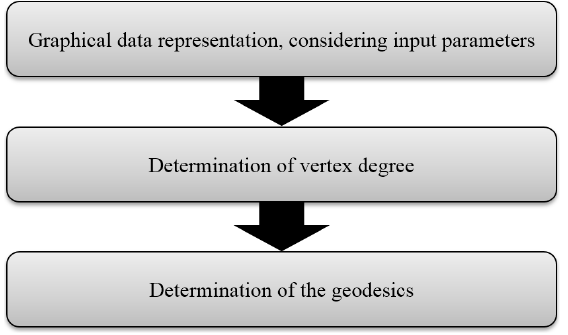
and acceptors (A), but cannot perform analyses in graph formalism, e.g., geodesics, nor identify water- mediated hydrogen bond bridges. The existence of a hydrogen bond was determined by a geometrical criterion, i.e., r (DA) ≤ 0.35 nm and α (HDA) ≤ 30°